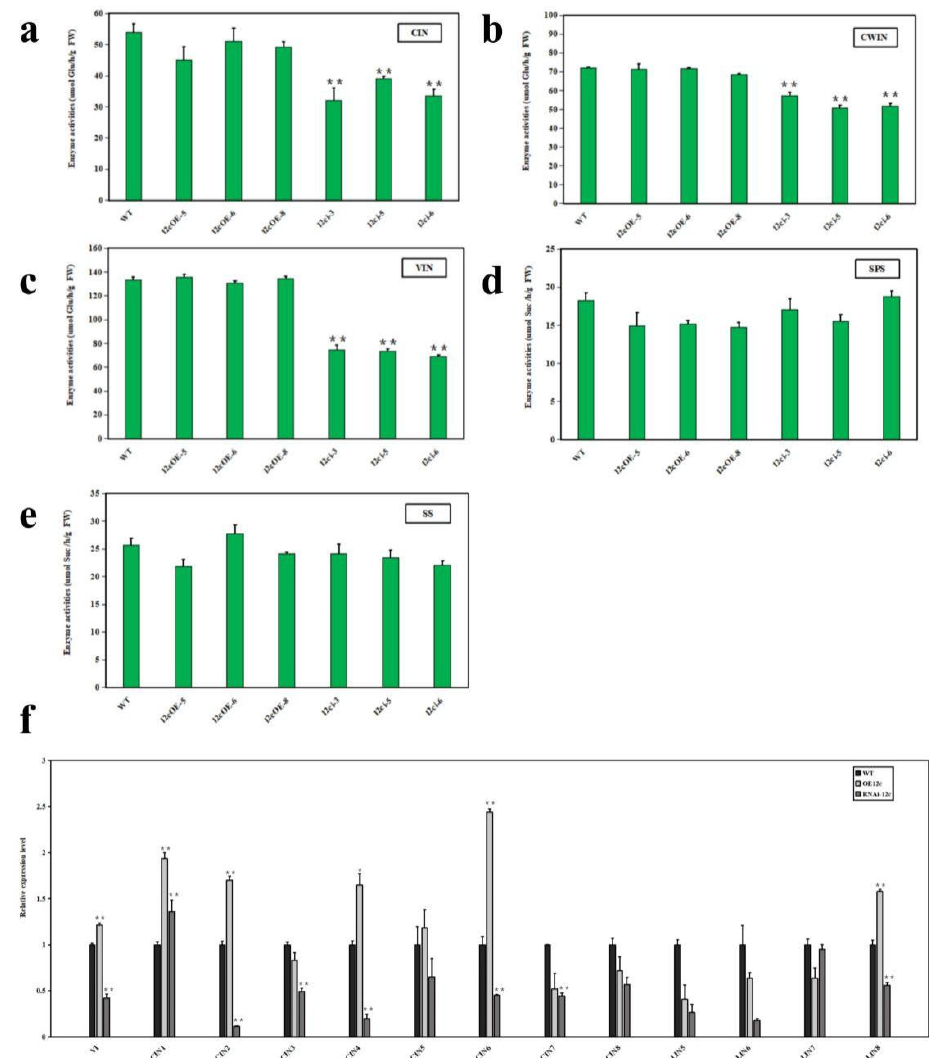
Figure 7. Invertase and sucrose synthase enzyme activities and related gene expression levels in RR fruits of WT and SlSWEET12c OE and RNAi lines: ( a – c ) enzyme activities of invertases (CIN, CWIN, and VIN) and ( d , e ), enzyme activities of sucrose synthases (SS and SPS) in SlSWEET12c transgenic plants (OE-12c and RNAi-12c ; n ≥ 20). ( f ) Transcript levels of sucrose invertase-related genes at the red ripening stage. The WT expression data were normalized to 1, and the actin gene was used as an internal reference. Statistical significance is indicated by * ( p < 0.05) and ** ( p < 0.01). FW—fresh weight. The experiments were repeated at least three times, with similar results.